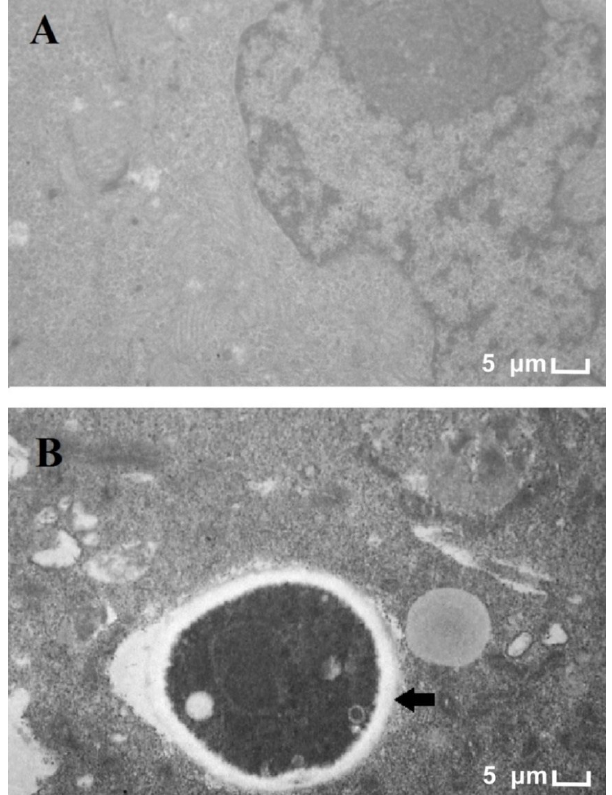
Figure 1. The transmission electron microscopy of the Trichophyton rubrum -HaCat co-culture after 24 h. ( A ) Human keratinocytes (HaCat) keratinocyte as the control (14kx); ( B ) Co-culture (14kx). The arrow indicates a fragment of T. rubrum hyphae inside the HaCat cells.